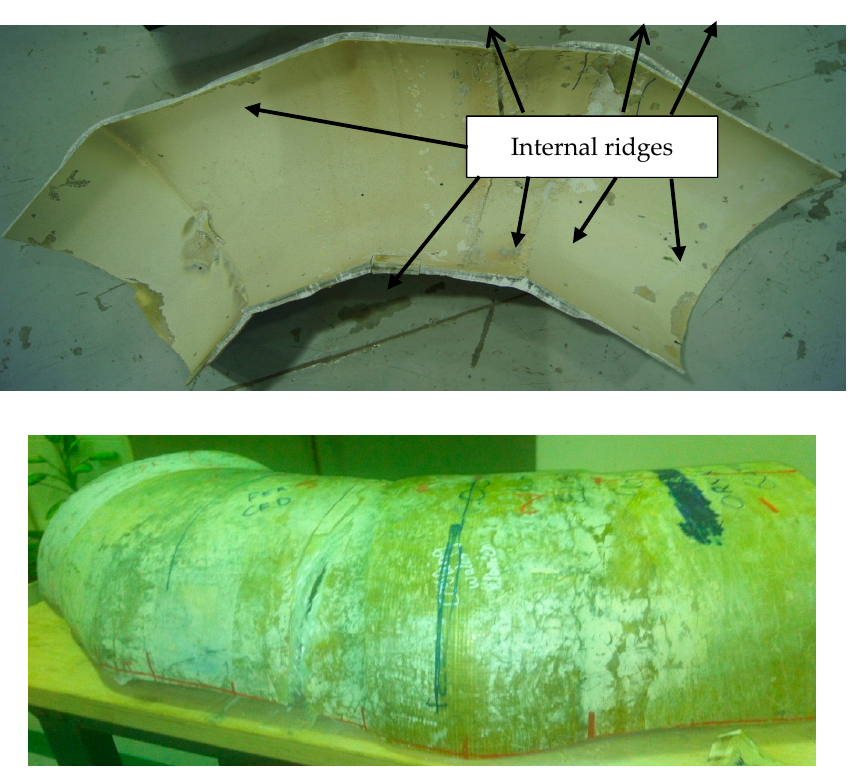
Figure 15. Internal surface of GFRP elbow showing internal ridges.